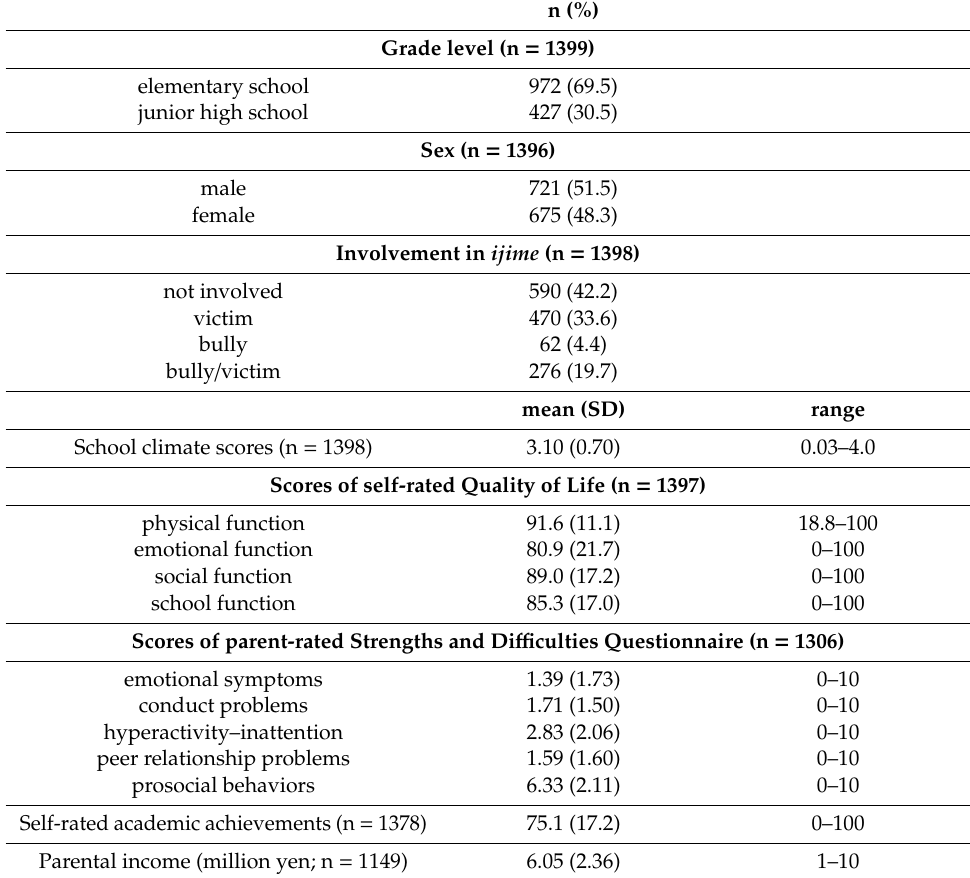
Table 1. Demographic characteristics of study